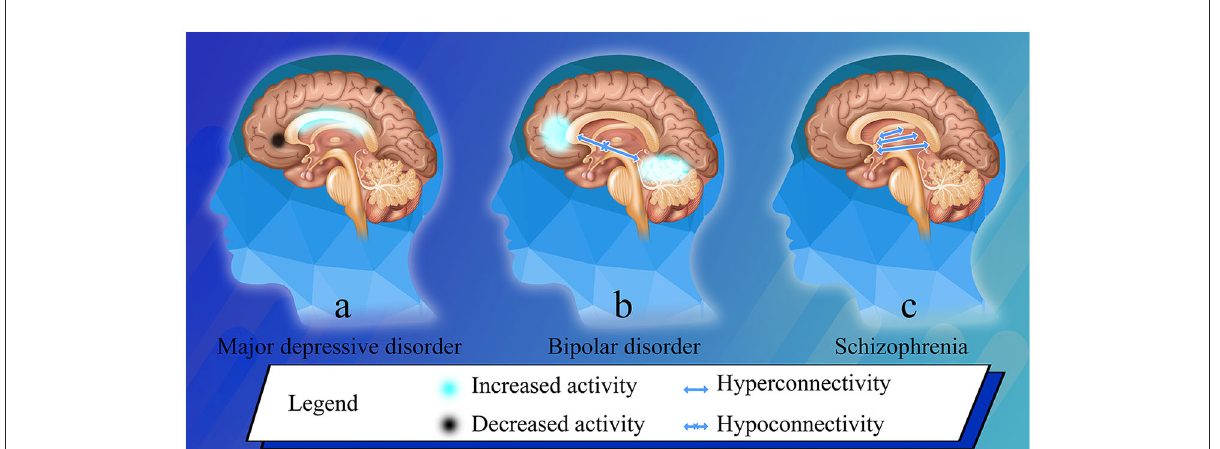
FIGURE1 Brain phenotypes in bipolar disorder and schizophrenia, and post-treatment changes in major depressive disorder. (a) After ECT in major depressive disorder patients, the low-frequency fluctuation amplitude of the right precentral gyrus significantly reduced; the degree centrality decreased in the left triangle part of the inferior frontal gyrus, and increased in the left hippocampus (1). (b) Resting stage functional connectivity between the whole vermis and the ventral prefrontal cortex, and between the anterior vermis and the middle cingulate cortex significantly decreased in bipolar disorder patients ( 2). (c) The regional function increased in the lentiform nucleus, which is related to hyperactivity of dopamine